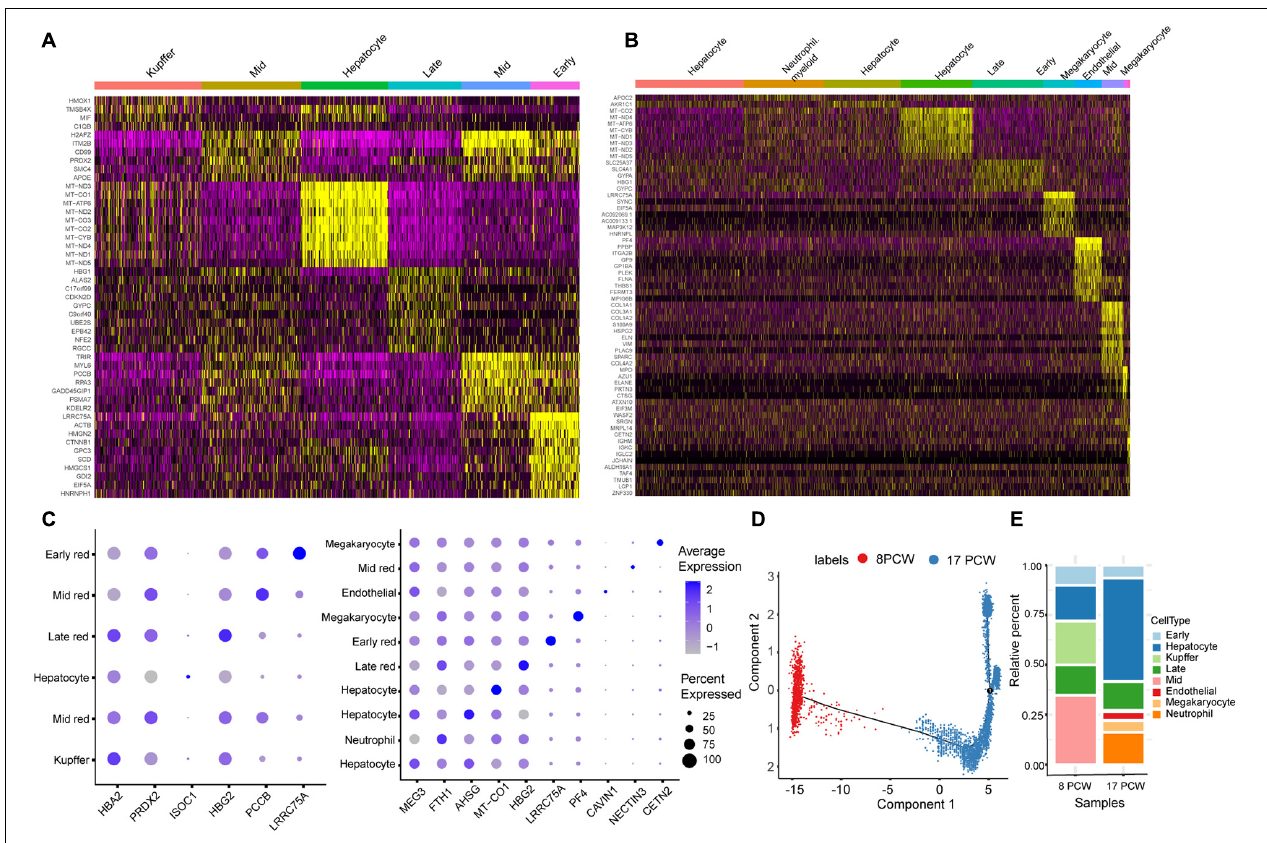
FIGURE 3 | The specificity of marker gene expression. (A,B) Heatmap of standardized expression for the top 10 marker genes identified for each cell type in the 8 PCW (A) and 17 PCW liver (B) . Each row represents a signature gene, and each column represents a cell. Yellow indicates high expression of a particular gene, and purple indicates low expression. (C) The dot plot shows the relative expression of signature genes in each cell type of the 8 PCW (Left) and 17 PCW liver (Right). Gene-expression frequency (percentage of cells within each cell type expressing the gene) is indicated by spot size, and expression level is indicated by color intensity. (D) Pseudotime analysis shows the differentiation and relation of all spots in 8 PCW and 17 PCW live tissue. (E) Plot showing the proportional contribution of cell types identified in panel (E) to the fetal liver tissue over developmental time. PCW, post-conception